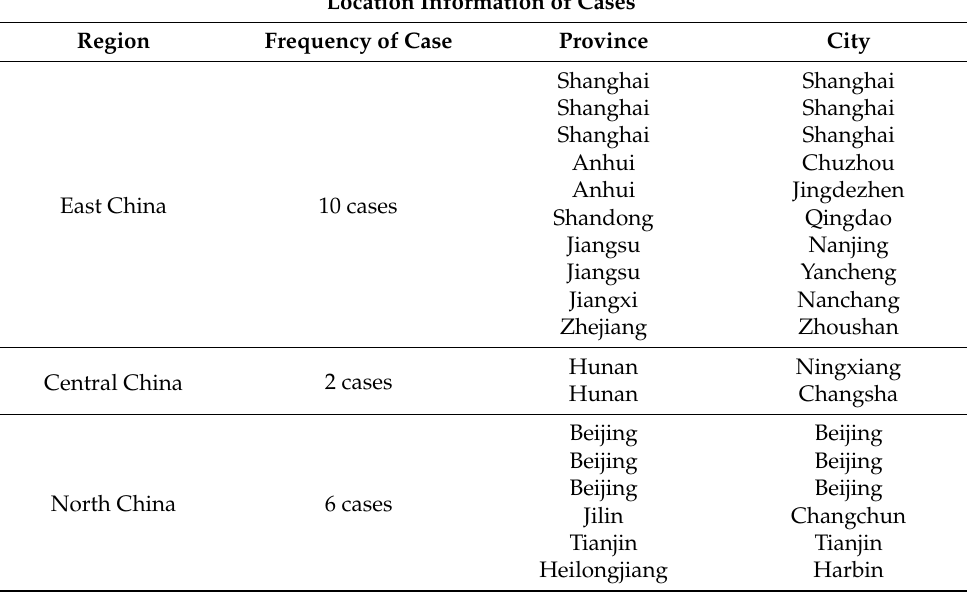
Table 5. Location information of